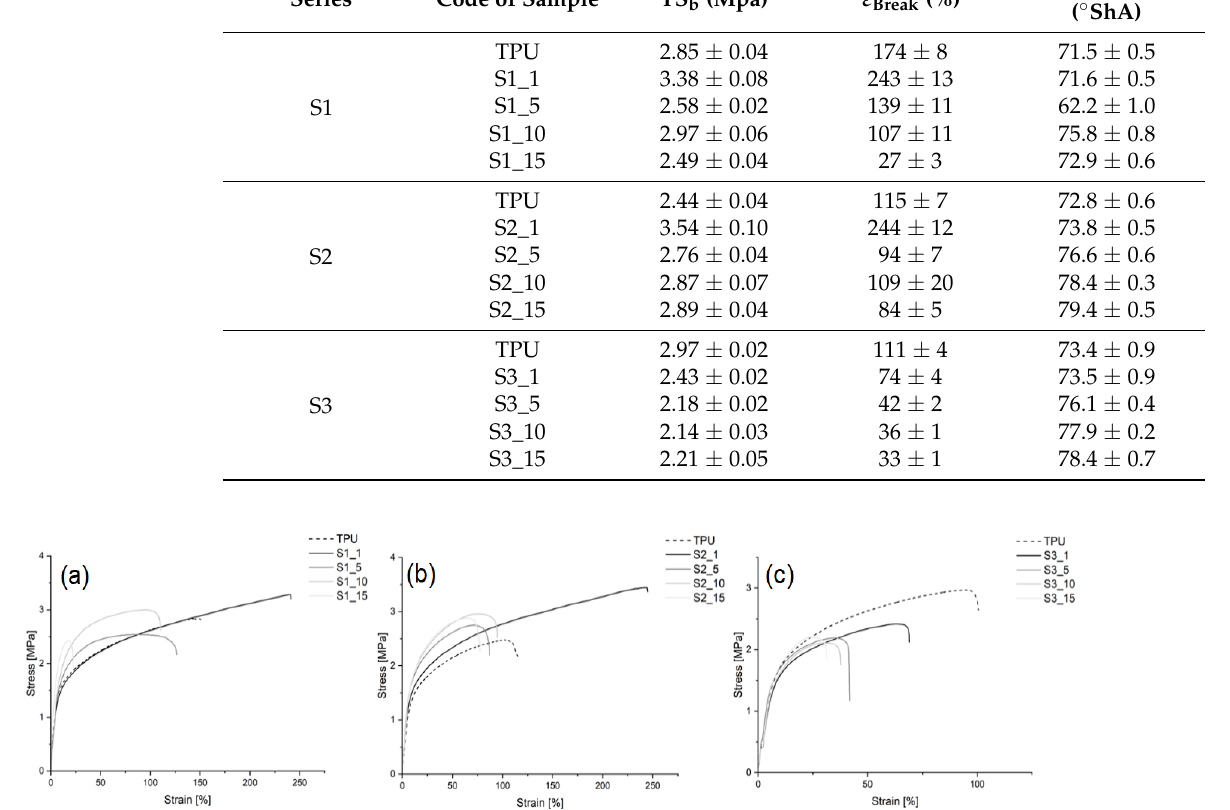
Table 3. Tensile strength ( TS b ), elongation at break ( ε Break ) and hardness determined for bio-TPU matrices and bio-TPU – ABW composites.